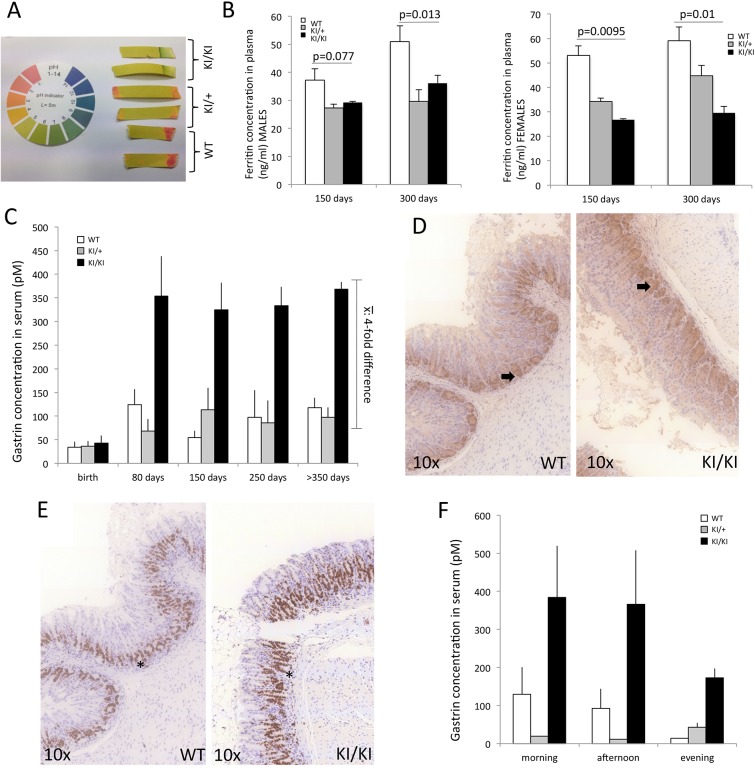
Hypoacidity, anemia and hypergastrinemia in KI/KI mice. (A) Gastric pH values determined by direct measurement with colorimetric paper at necropsy. Measurements of two different animals are shown for each genotype; gastric pH values were ∼1, ∼4 and ∼7 for WT, KI/+ and KI/KI mice, respectively. (B) Ferritin concentrations in plasma (mM) of WT, KI/+ and KI/KI male (left) and female (right) mice. (C) Gastrin concentrations in serum (pM) of WT, KI/+ and KI/KI mice at ages indicated. (D) Representative IHC images of the antrum region of the stomach stained with anti-gastrin antibody in WT and KI/KI mice at 350 days of age. In both genotypes, the anti-gastrin antibody labels G-cells at the base of pyloric glands (black arrows). (E) IHC with anti-Ki67 antibody of the gastric antrum from representative WT and KI/KI mice. In both genotypes, progenitor cells are located at the base of pyloric glands (asterisks). (F) Gastrin concentrations in serum (pM) of WT, KI/+ and KI/KI mice. n=6 per genotype. ns, not significant. Data in B,C,F are represented as mean±s.d.